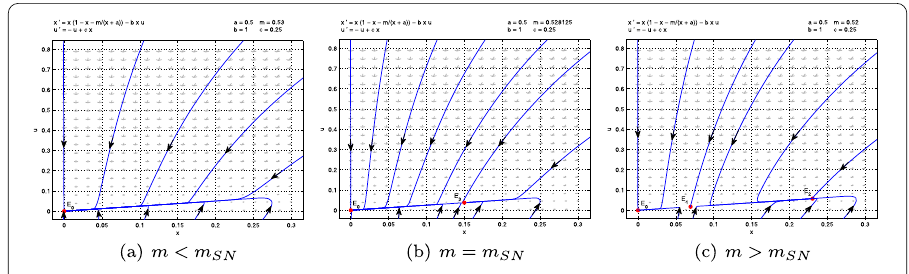
Figure 4 The saddle-node bifurcation of system